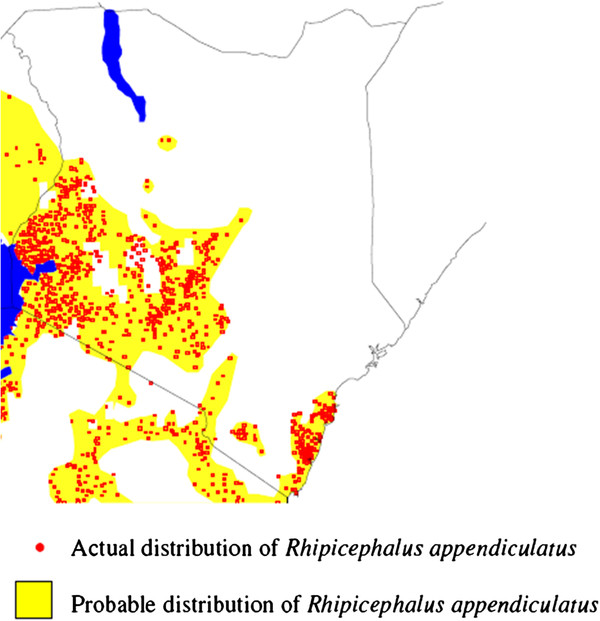
Map of Kenya illustrating the distribution of ECF vector tick. Source: [28].